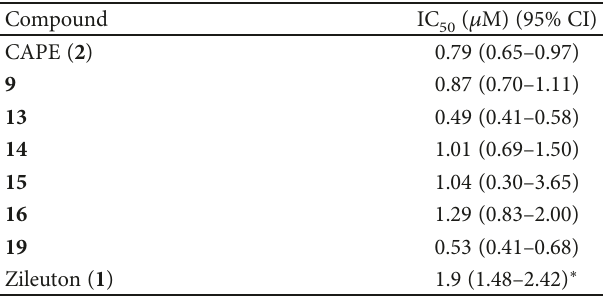
Table 1: Calculated IC values of selected compounds for the 50 inhibition of 5-LO product biosynthesis in human